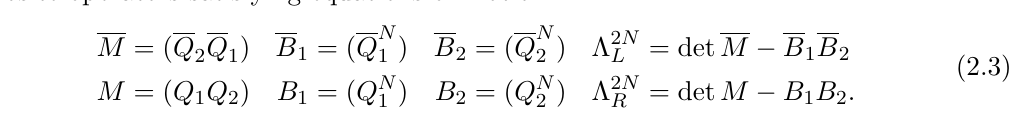
Table 1 . U(1) PQ charges and representations under the gauged G L SU( N ) 1 SU( N ) 2 symmetries are indicated for the bifundamental quarks (upper half) and com- (cid:2) posite operators resulting from G L G R con(cid:12)nement (lower half). (cid:2) Below the scales (cid:3) and (cid:3) , the low energy degrees of freedom are described by L R